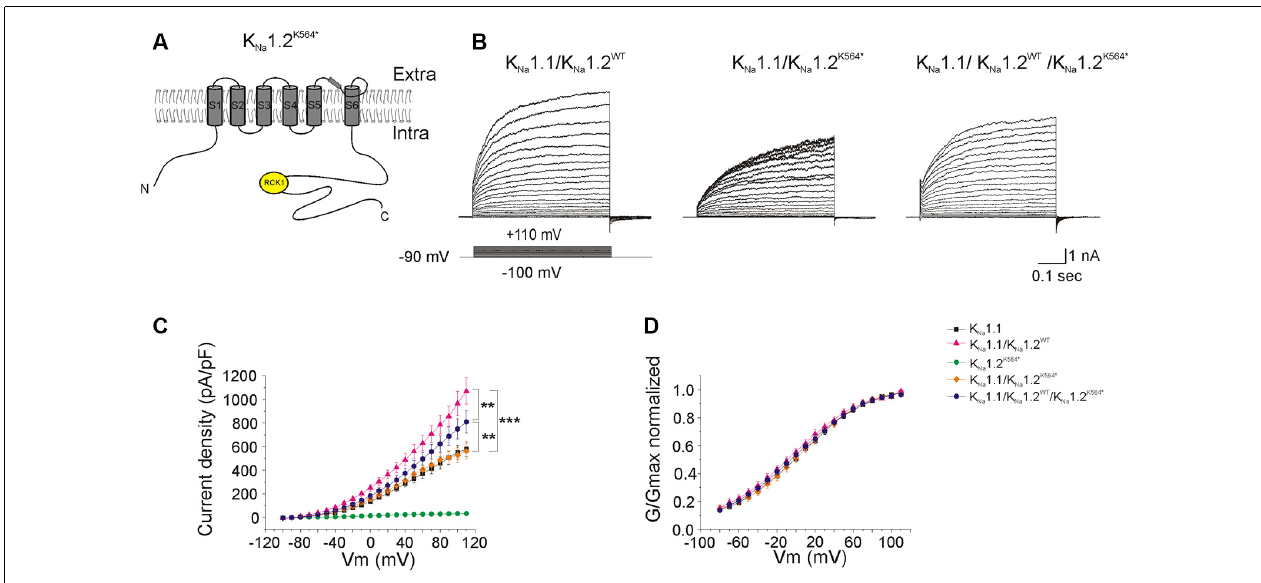
FIGURE 5 | Functional consequences of the p.K564 ∗ mutation on heteromeric channels. (A) Schematic representation of the expected K Na 1.2 K564 ∗ mutant subunit. The nonsense mutation locates in the C-terminal part of the protein between the RCK1 and RCK2 domains, leading to a predicted truncated protein. (B) Representative current responses to depolarizing voltage steps in CHO cells transfected with K Na 1.1 + K Na 1.2 WT (left traces); K Na 1.1 + K Na 1.2 K564 ∗ (middle traces); K Na 1.1 + K Na 1.2 WT + K Na 1.2 K564 ∗ (right traces) plasmids. (C) Current densities measured in these three conditions but also including K Na 1.1 and K Na 1.2 WT for comparison. (D) Conductance-voltage relationship of wild type homomeric K Na 1.1; wild type heteromeric K Na 1.1 + K Na 1.2; heteromeric mutant K Na 1.1 + K Na 1.2 K564 ∗ and heteromeric mutant K Na 1.1 + K Na 1.2 WT + K Na 1.2 K564 ∗ channels normalized. Two-way ANOVA with Tukey’s correction for multiple comparison. *** p < 0.001; ** p <